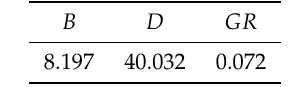
Table 3. Measures of game refinement for classical DouDiZhu.